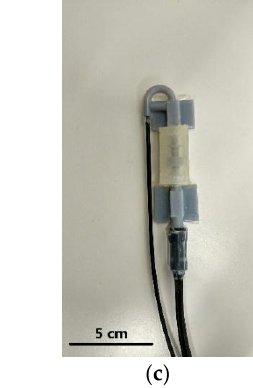
Figure 1. ( a ) Inclinometer. ( b ) Biometrics goniometer. ( c ) Plastic optical fiber (POF) sensor.